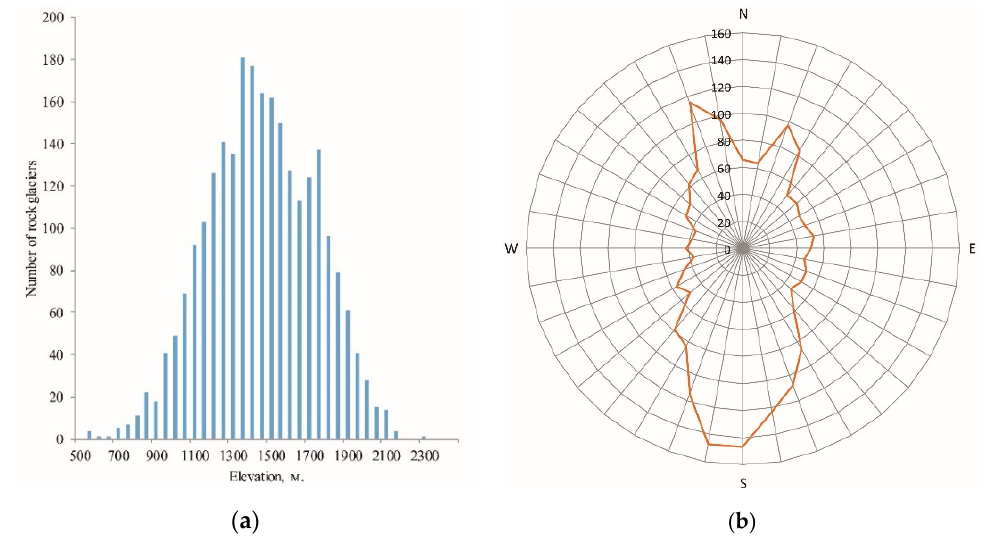
Figure 5. Distribution of mean absolute altitudes ( a ) and exposure of slopes ( b ) of rock glaciers on Chersky Range.